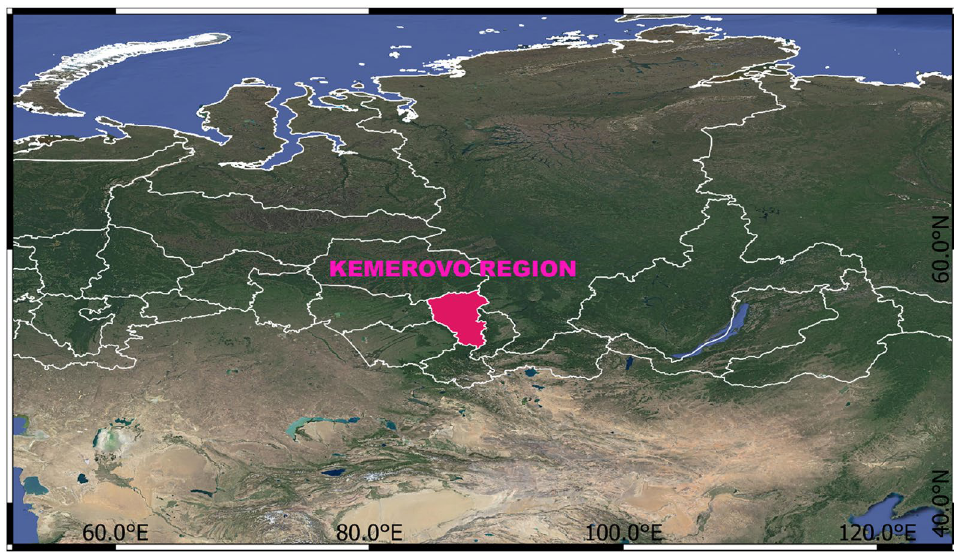
Figure 1. Location of the Kemerovo region (pink area). Top-level administrative boundaries in Russia are shown in white. The satellite map provided by Google Maps is embedded using the QucikMapServices plugin of QGIS software (0.19.29 https:// nextg is. com/ blog/ quick mapse